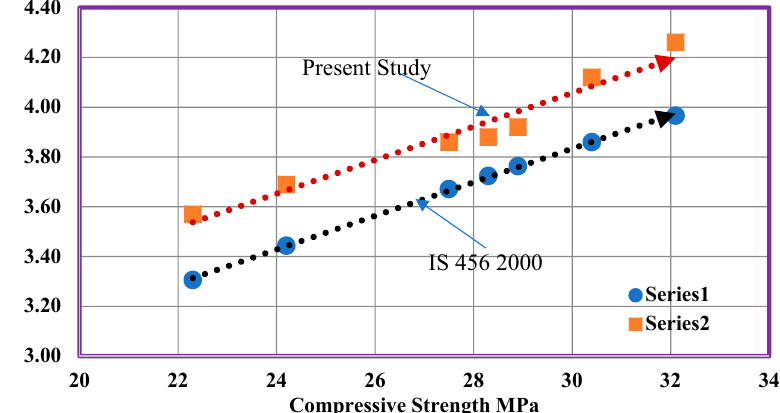
Figure 11. A study of flexural strength and compressive strength of concrete, containing different percentages of FS as well as CS. Figure 12 indicates that the flexural strength measured using Equation (1) was plot- ted against the experimental values. There exists a strong relationship with the measured and experimental flexural strength values, which is evident from the R 2 value (0.94).